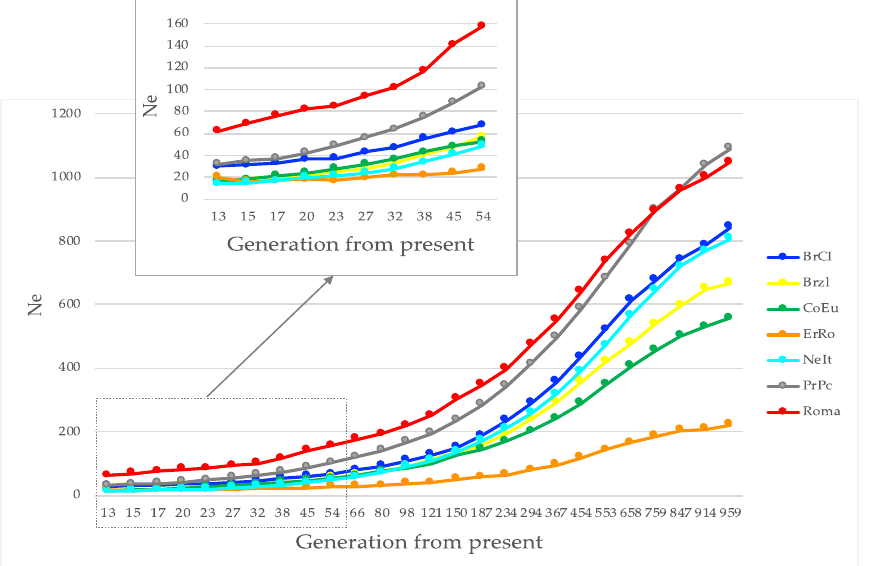
Figure 2. Effective population size (Ne) calculated up to about 950 past generations for each breed.